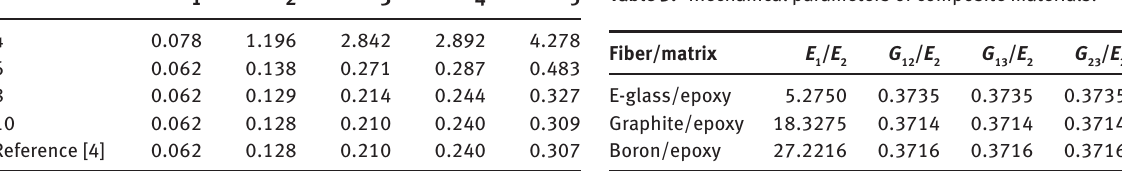
Table 3: Mechanical parameters of composite